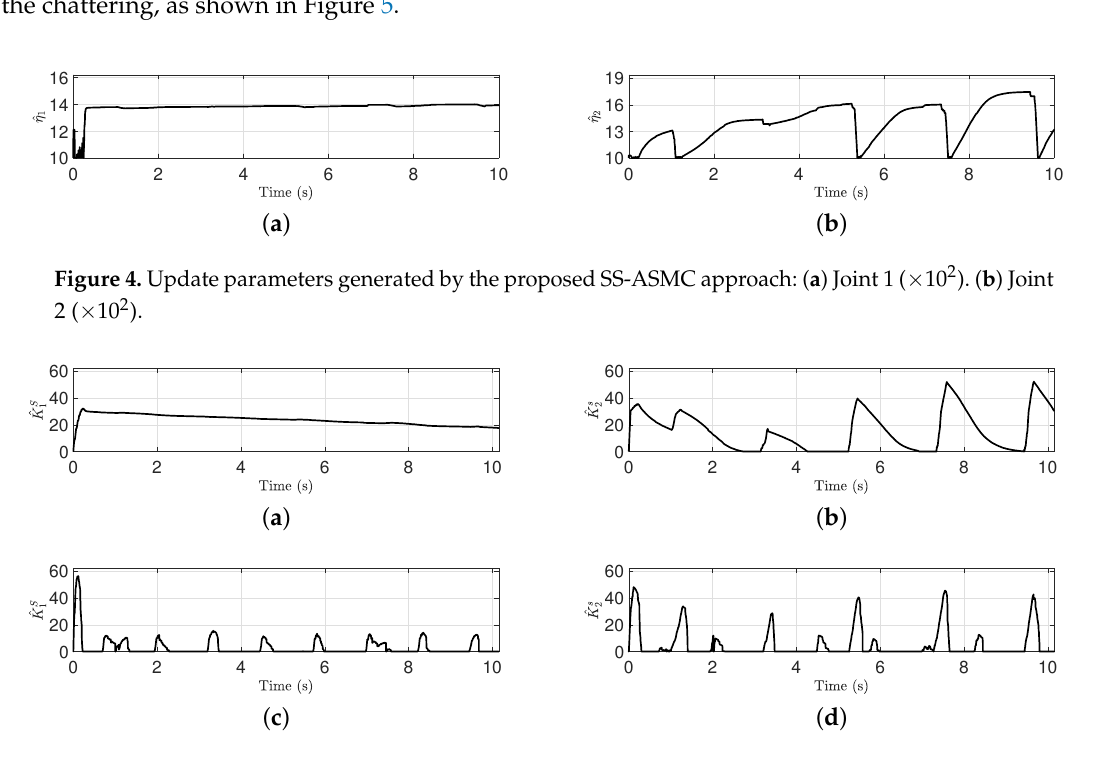
Figure 5. A comparison between the switching gains of the proposed SS-ASMC approach and the existing ASMC approach: ( a ) Switching gain of the proposed SS-ASMC approach for the Joint 1 ( × 10 2 ). ( b ) Switching gain of the proposed SS-ASMC approach for the Joint 2 ( × 10 2 ). ( c ) Switching gain of the ASMC approach for the Joint 1 ( × 10 2 ). ( d ) Switching gain of the ASMC approach for the Joint 2 ( × 10 2